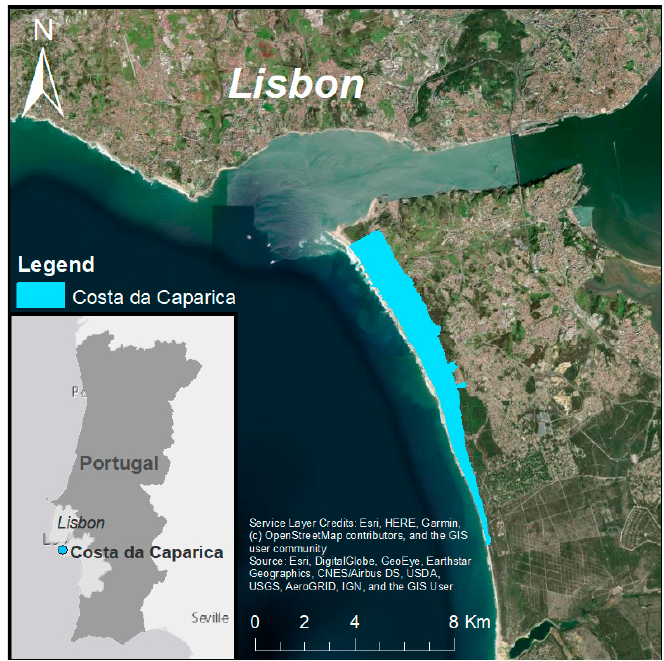
Figure 1. Location of the study site (Costa da Caparica, Portugal).